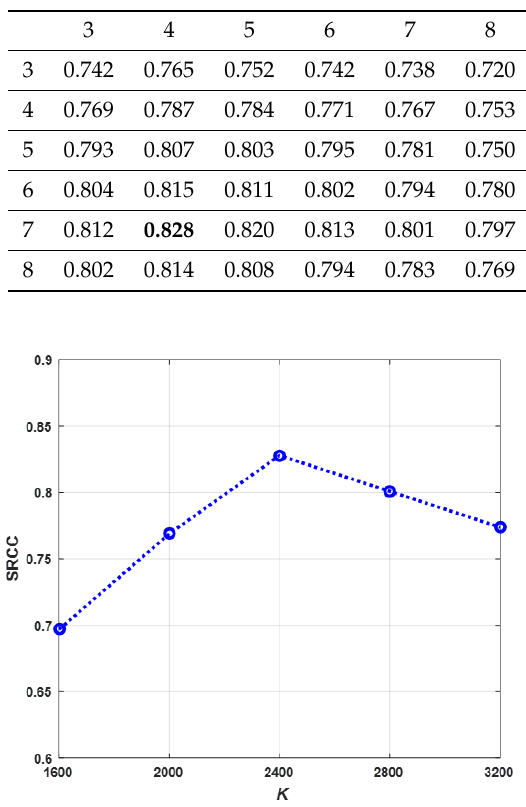
Figure 6. The SRCC of the proposed HPSC+DAP under different K on the CSIQ